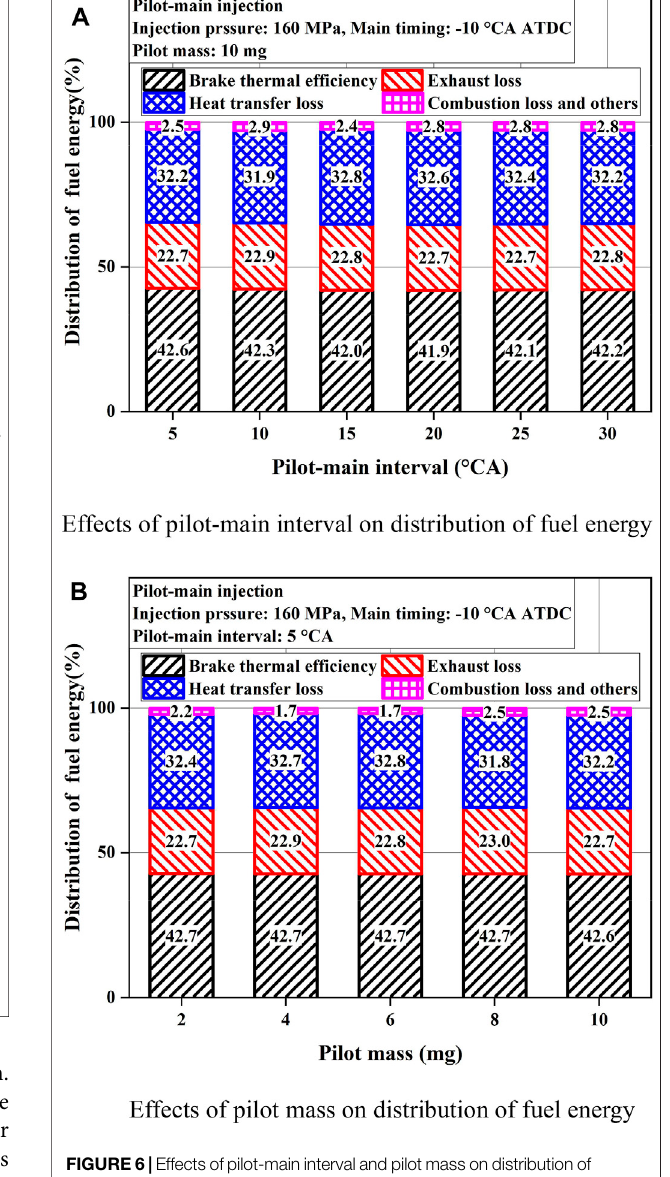
FIGURE6| Effects ofpilot-mainintervaland pilotmasson distribution of fuel energy. (A) Effects of pilot-main interval on distribution of fuel energy, (B) Effects of pilot mass on distribution of fuel